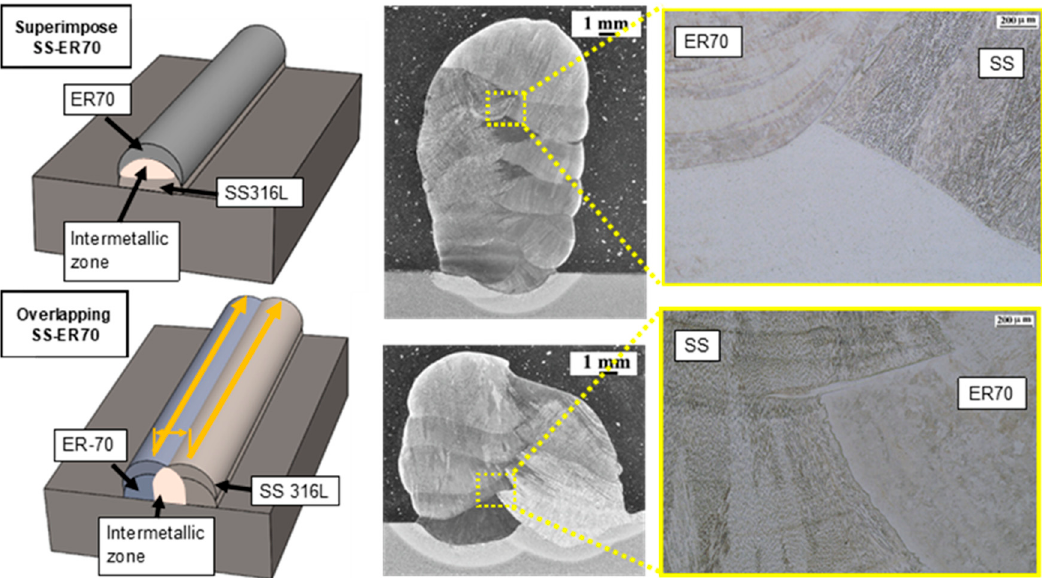
Figure 6. Macrostructure and microstructure of superimposed and overlapped SS-ER70 walls.